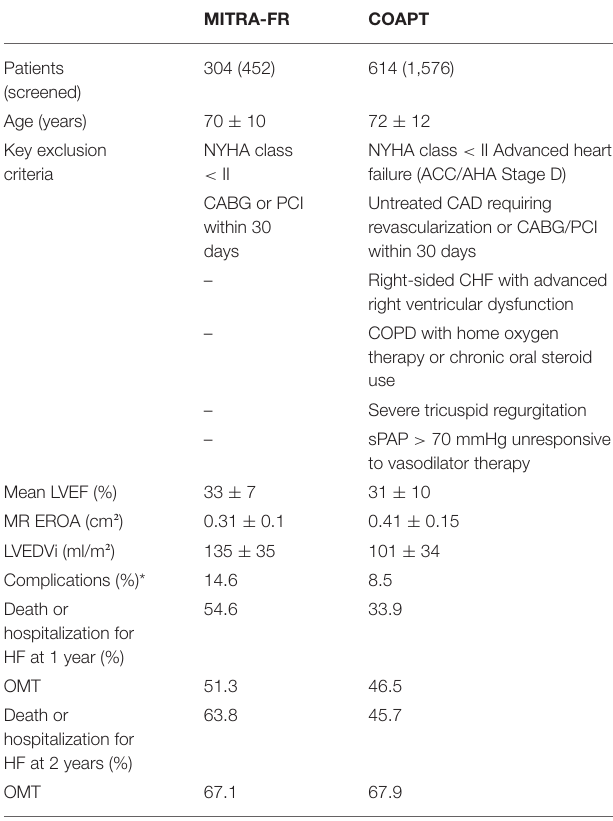
TABLE 1 | Key differences between the MITRA-FR and COAPT study [adapted from Praz et al.